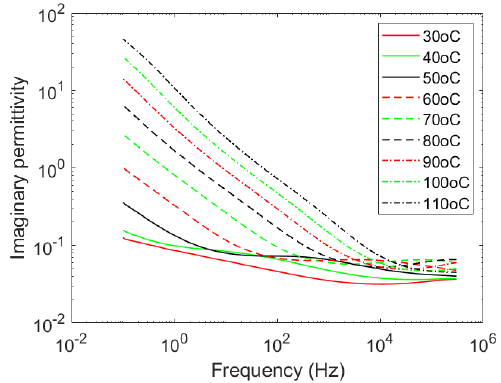
Figure 1. Imaginary part of the relative permittivity of unfilled fully-cured polyester resin at temperatures from 30 °C to 110 °C. temperatures from 30 ◦ C to 110 ◦